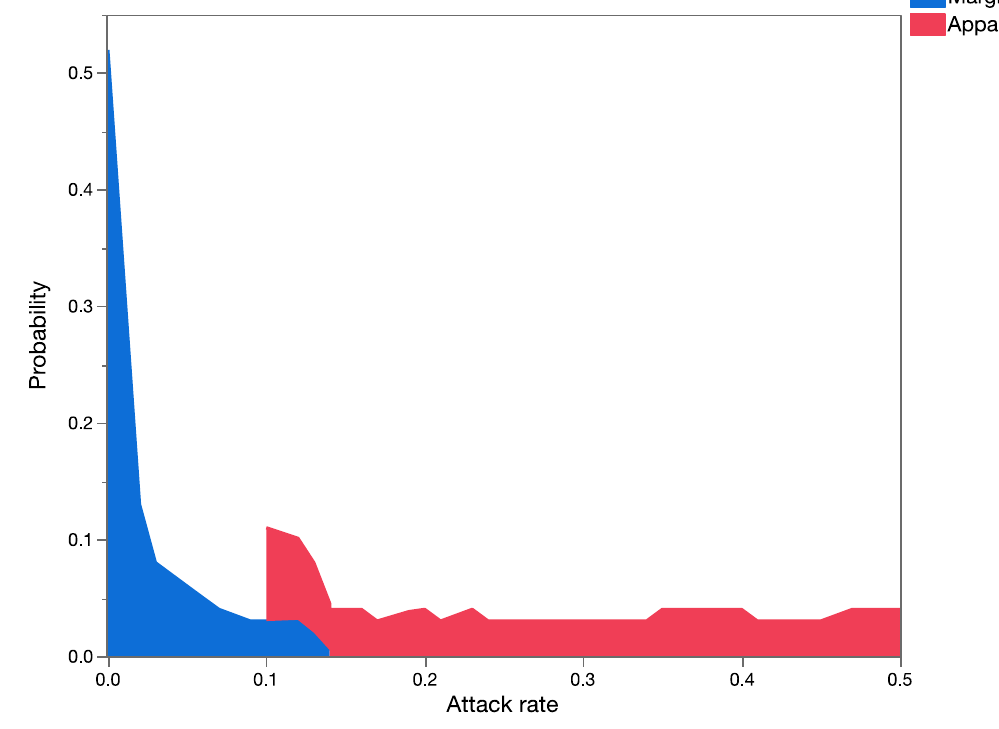
Figure 9. Overlay chart showing the probability distributions of marginal attack rate and apparent mortality (expressed as proportions on x-axis) for T. flavoorbitalis .